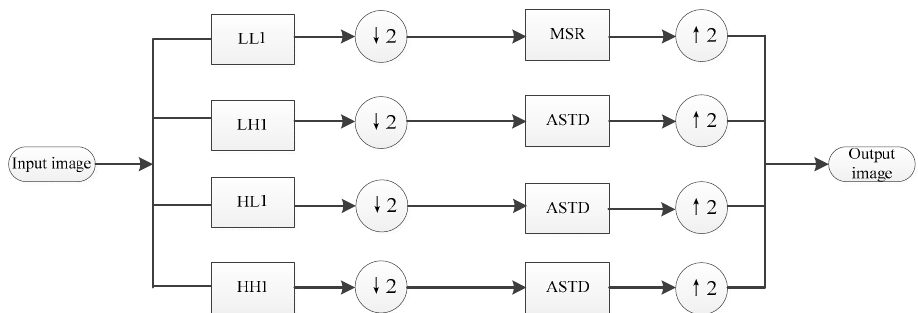
Figure 4. Block diagram for multi-scale Retinex algorithm.